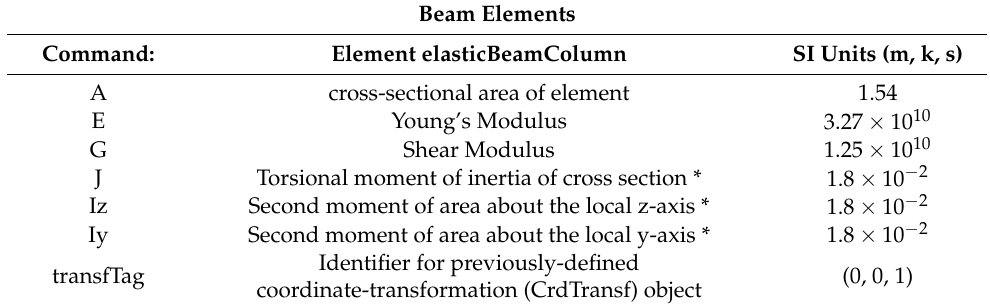
Figure 8. Finite element modeling of the bridge with the location of LRBPs. Table 1. Modeling the beams in the